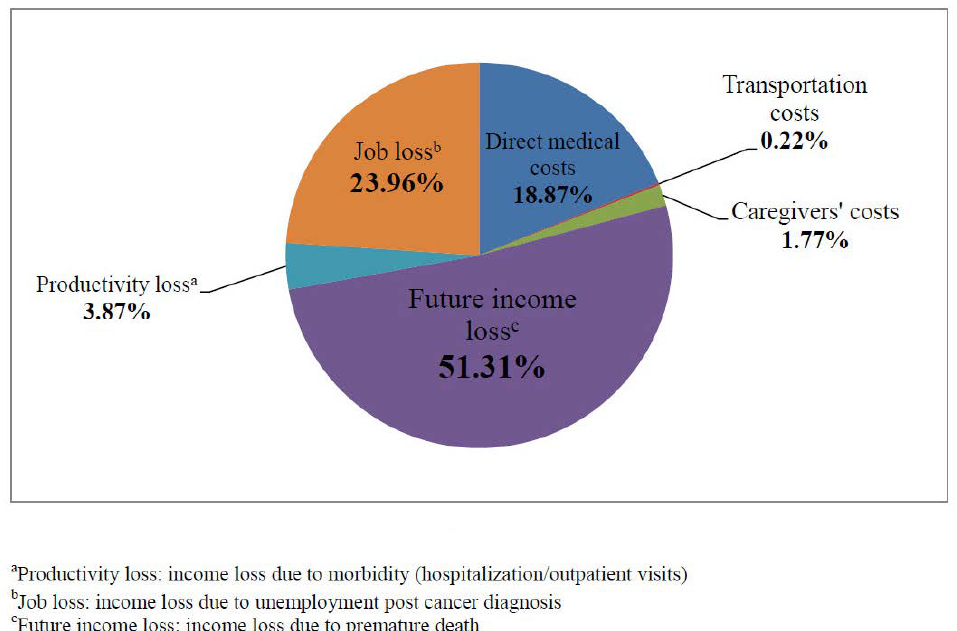
Figure A1. Proportions of cost components.